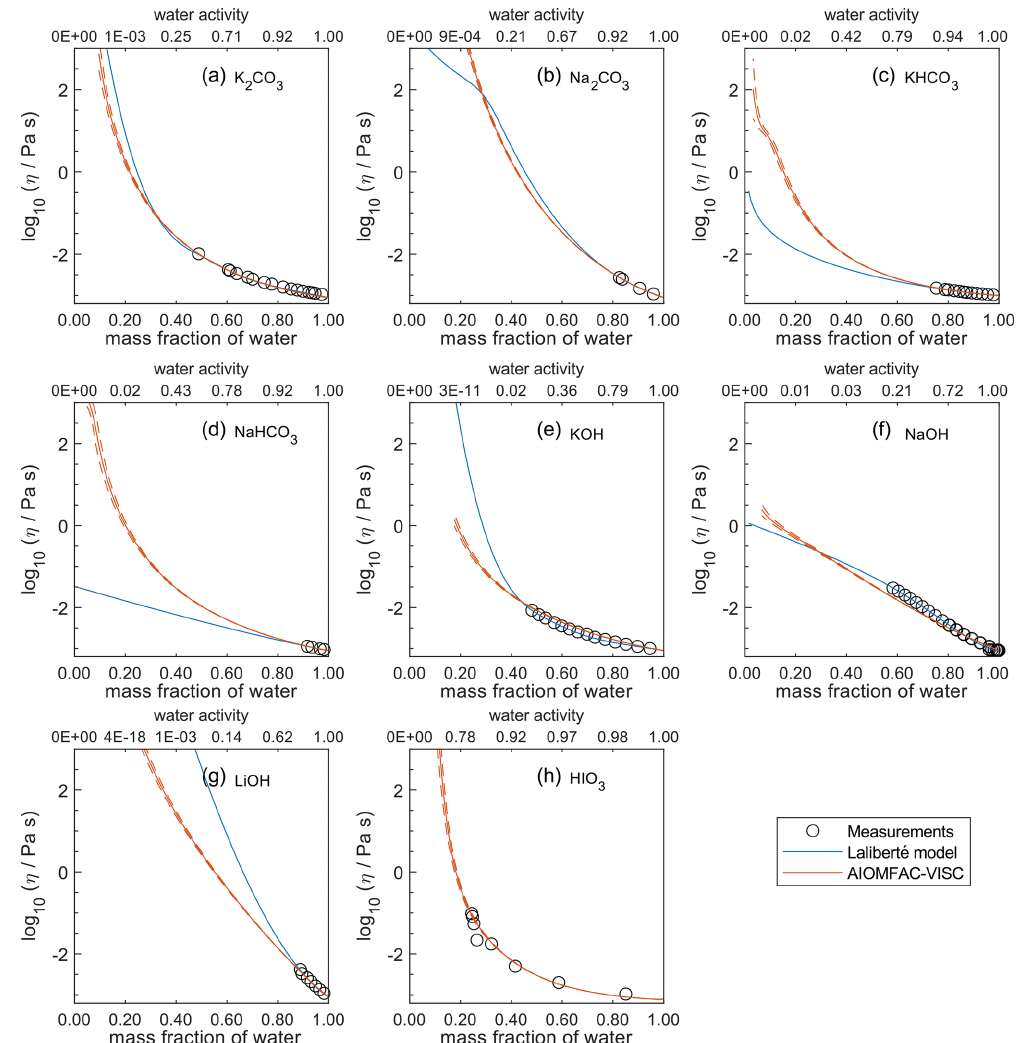
Figure 8. Comparison of the Laliberté model, AIOMFAC-VISC, and viscosity measurements versus mass fraction of water (bottom axis) and AIOMFAC-predicted water activity (top axis) for binary solutions of bromide and iodide salts at 298K with bulk measurements shown for 298 ± 1K unless otherwise indicated: (a) K 2 CO 3 , (b) Na 2 CO 3 , (c) KHCO 3 (293K), (d) NaHCO 3 , (e) KOH, (f) NaOH, (g) LiOH,